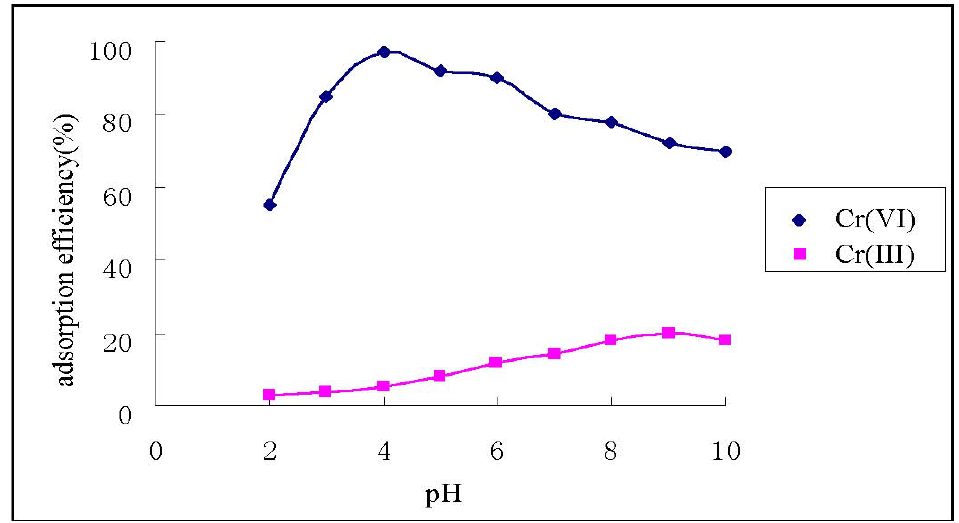
Figure 3. Effect of pH on the adsorption of Cr(VI) and